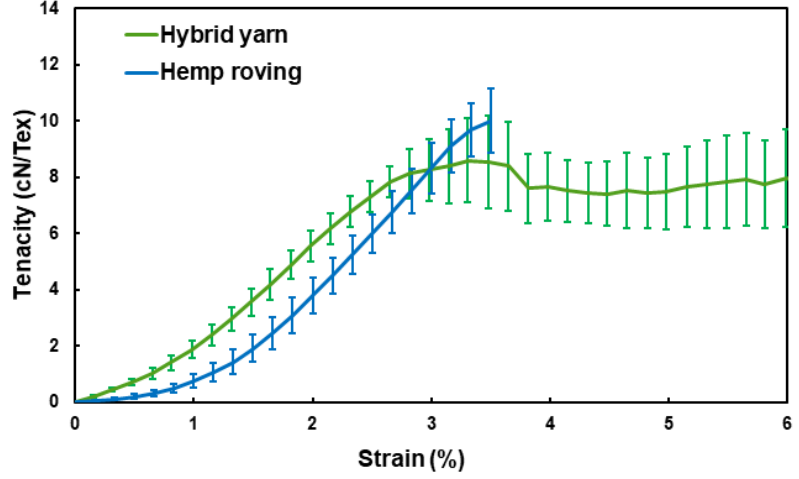
Figure 5. The tensile behaviour of the hybrid yarn and hemp roving alone.